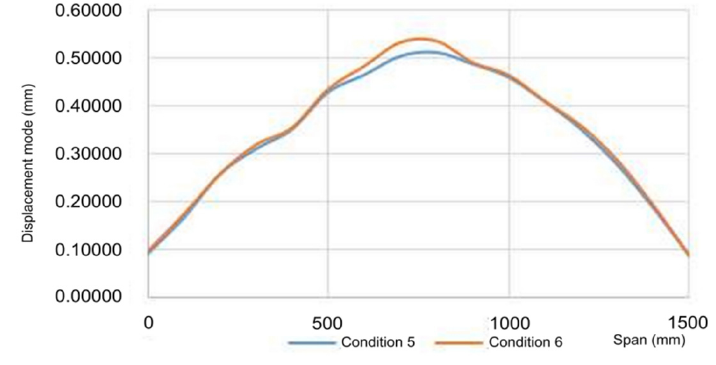
( a ) Comparison of the first-order vibration modes under Conditions 5 and 6. Figure 12. Cont